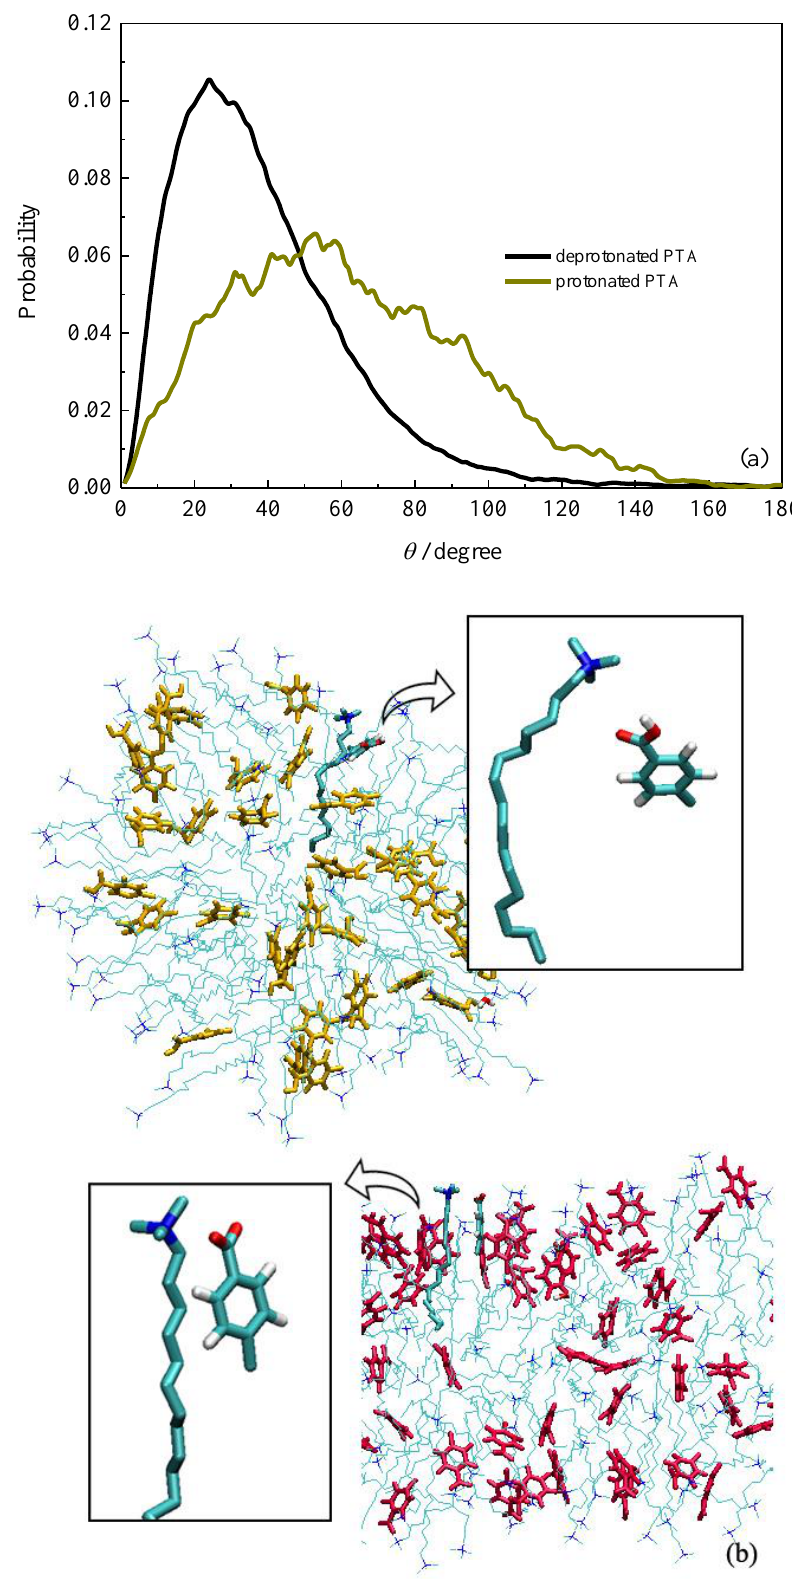
Figure 4. ( a ) Probability distribution of the angle between vectors defined in the molecular structures. ( b ) Bonding structures between CTA + and PTA in spherical and rod-like